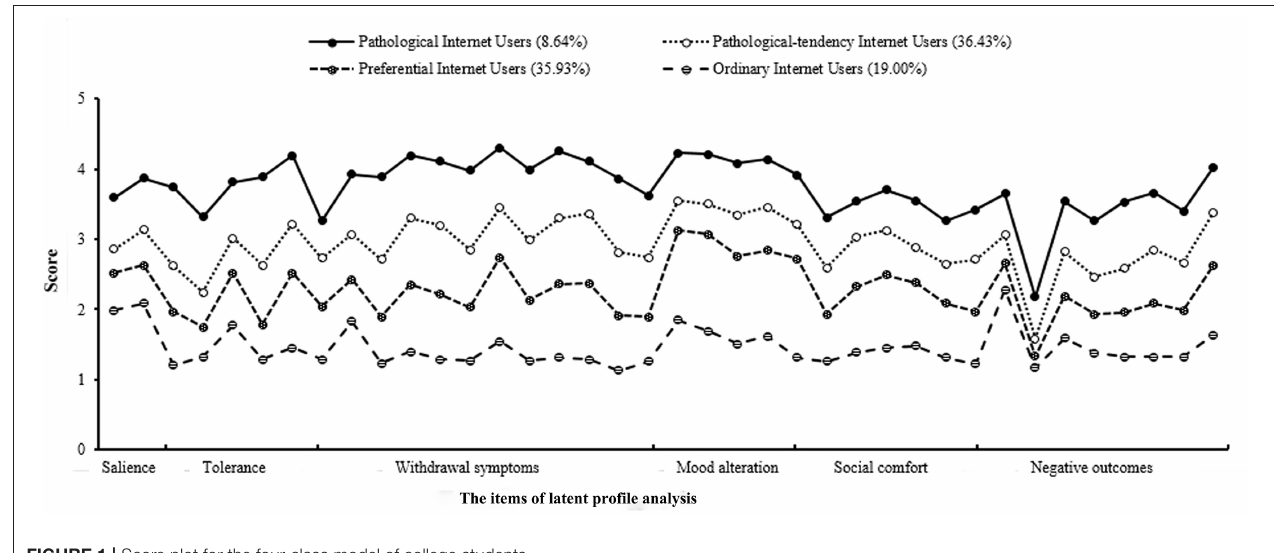
FIGURE 1 | Score plot for the four-class model of college students.